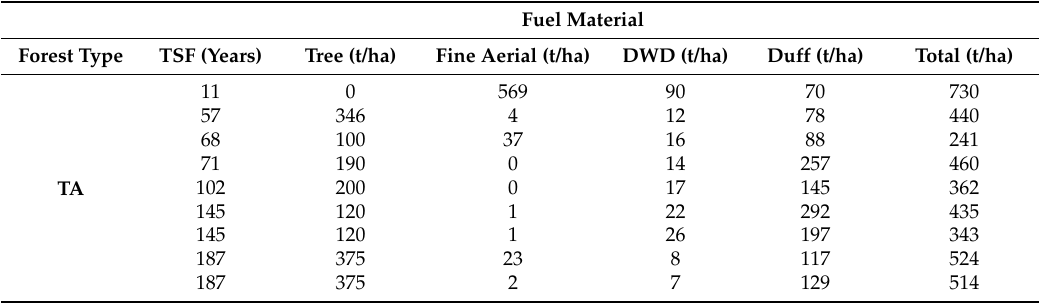
Table E1. Empirical TSF and fuel loads (tree, fine aerial vegetation, DWD, duff, and total) for TA, JP, BS-S, and BS-NS dominated